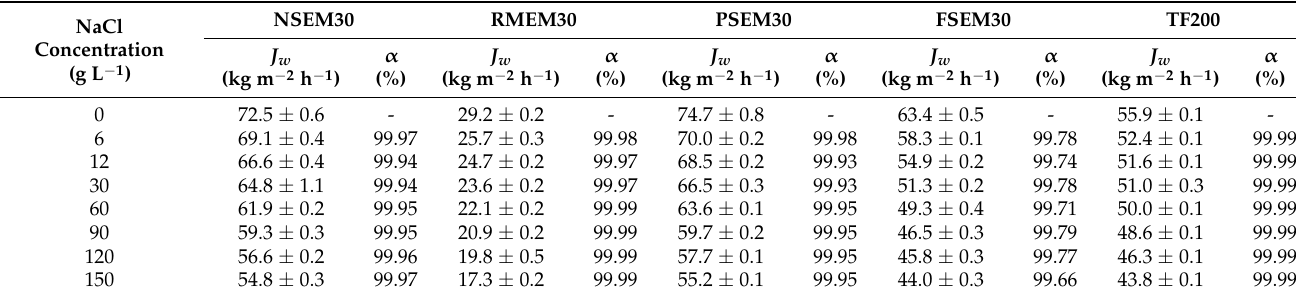
Table 2. DCMD permeate flux ( J w ) and salt rejection factor ( α ) of the unsupported and supported nanostructured membranes prepared with 30 min electrospinning time together with that of the commercial membrane TF200 for different NaCl feed